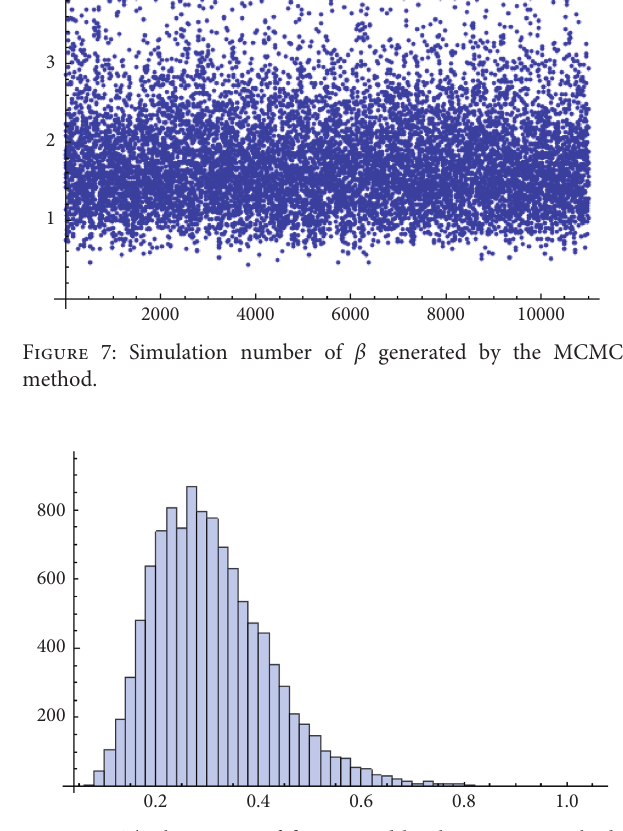
Figure 8: The histogram of β generated by the MCMC